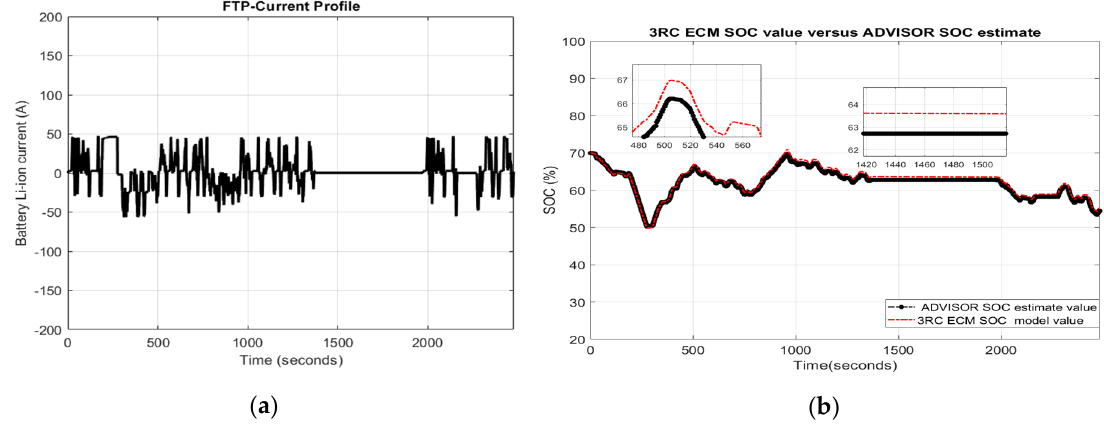
Figure 13. 3RC ECM Li-ion battery model ( a ) The Federal Test Procedure (FTP)-75 current profile test; ( b ) The corresponding 3RC ECM SOC true value versus ADVISOR state of charge (SOC) estimate (Li-ion battery model validation).